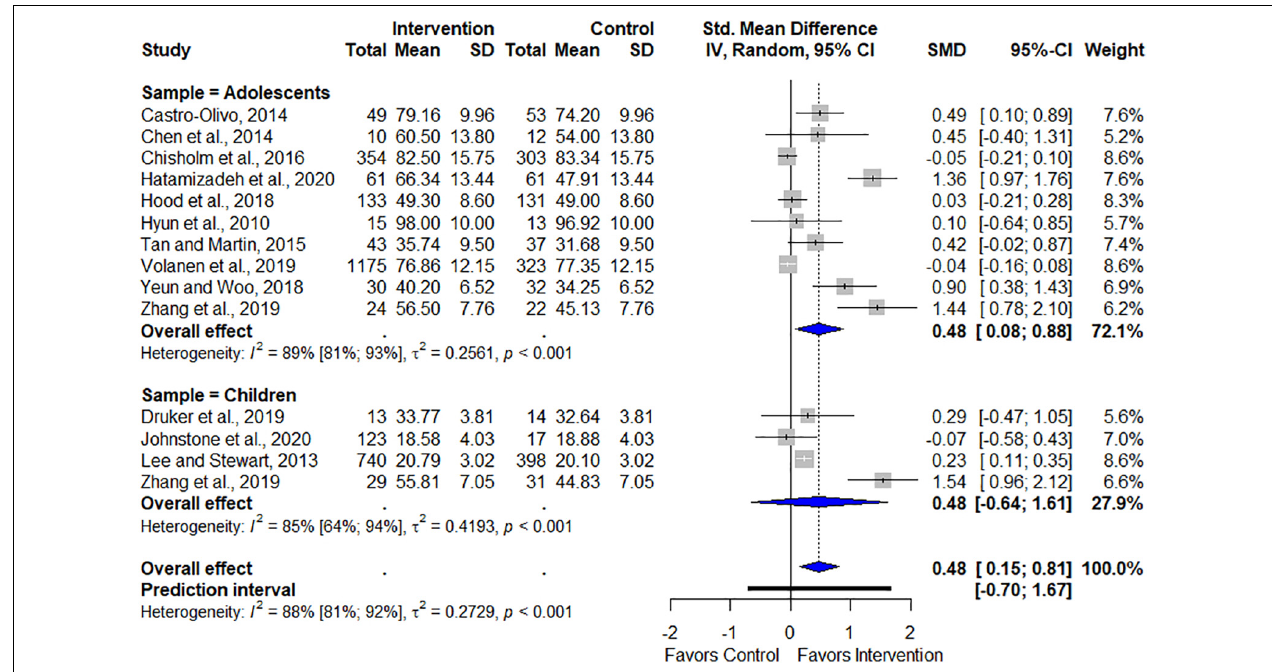
FIGURE 6 | Overall and subgroup effects of programs on